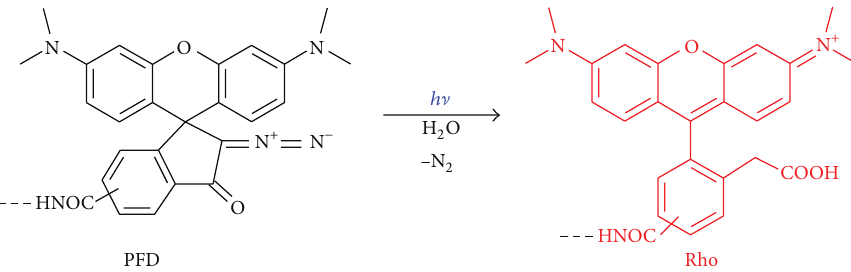
Figure 1: Chemical structures of precursors of fluorescent dyes PFD and the rhodamine dyes Rho formed by